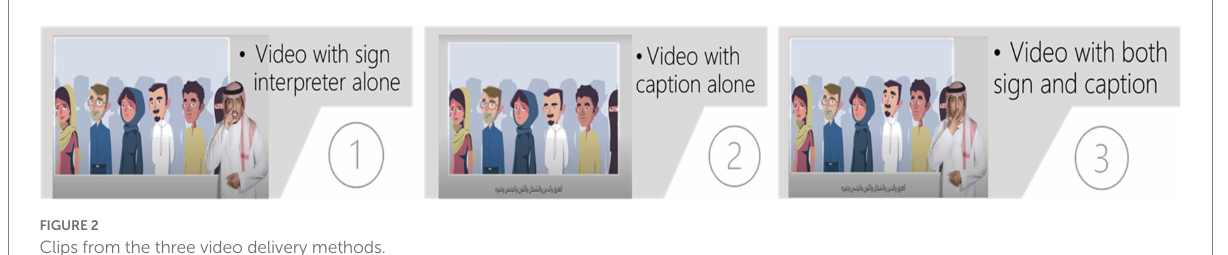
FIGURE 2 Clips from the three video delivery